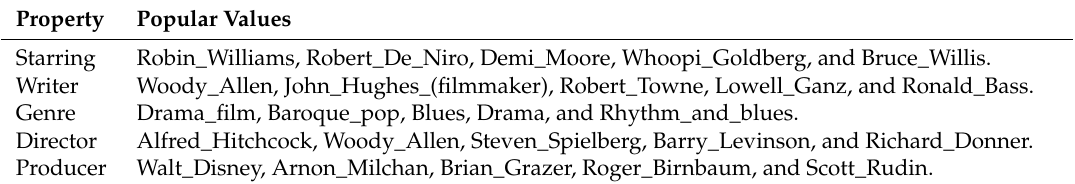
Table 4. Top 5 movie features for the selected properties in the knowledge graph.